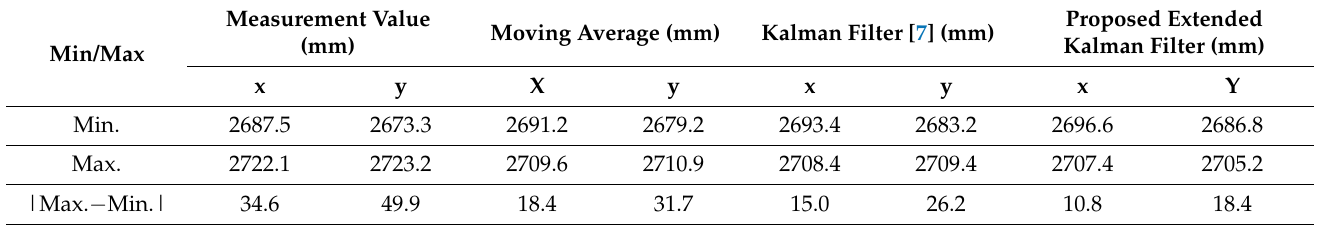
Table 4. Measurement data from sensor units and filtering